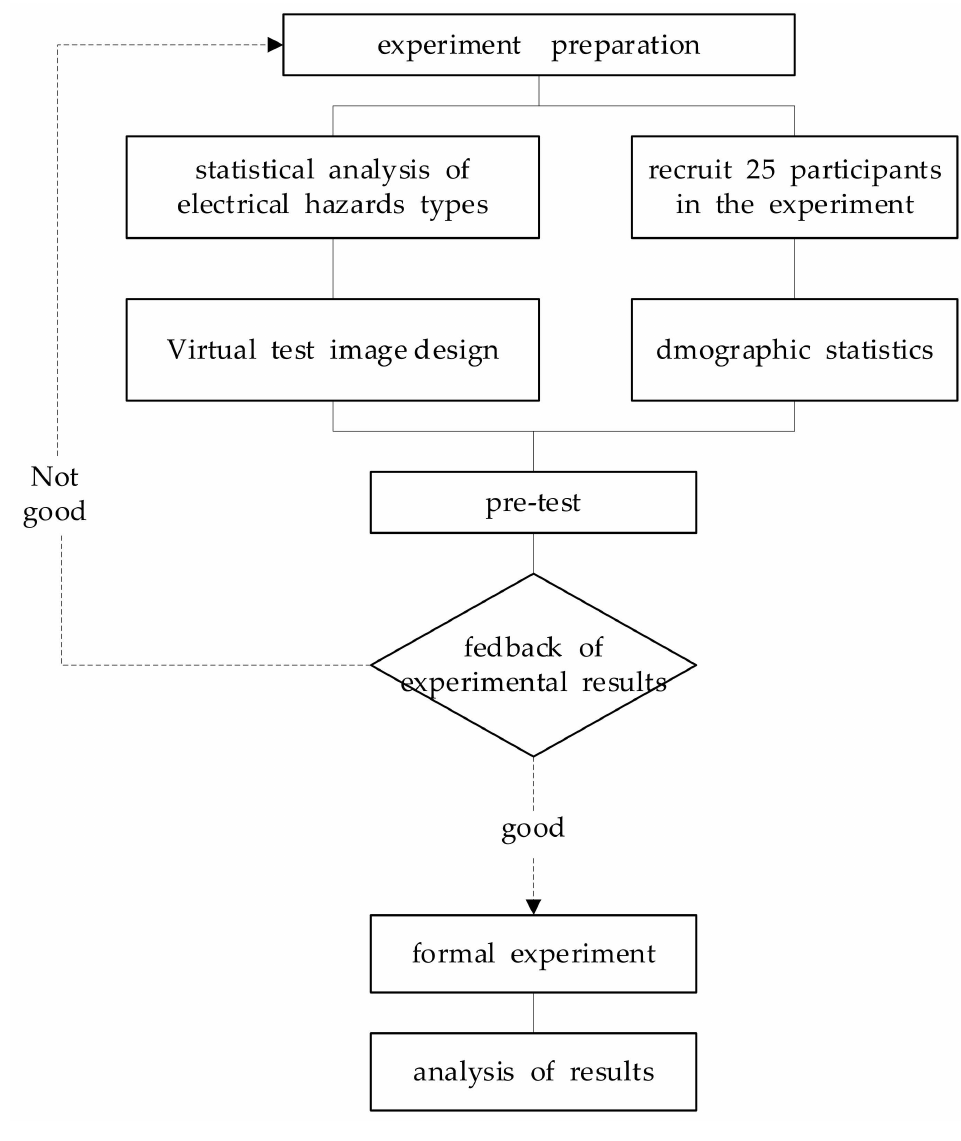
Figure 1. Experimental framework. Table 1. Hazard information